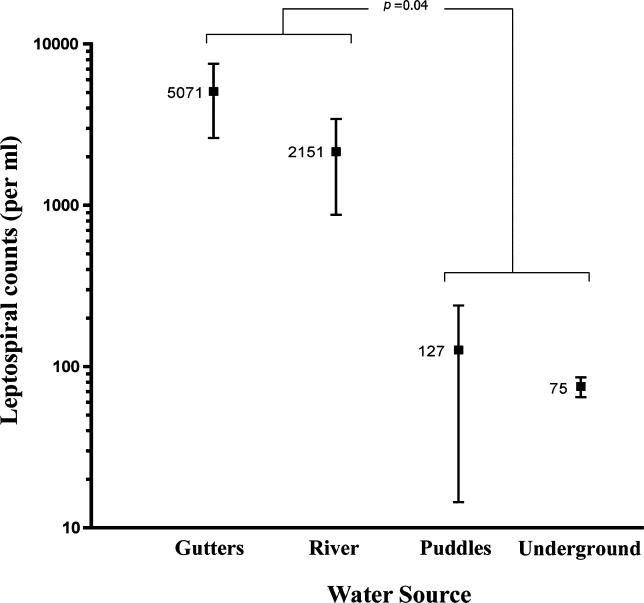
Comparison of Leptospiral Counts in the Belen Living Area, According to Water SourceMeans and 95% CIs are shown. Open gutters and river samples showed significantly higher bacterial counts than the samples from puddles and underground sources (unpaired t-test with Welch's correction: t = 2.284, p < 0.05).